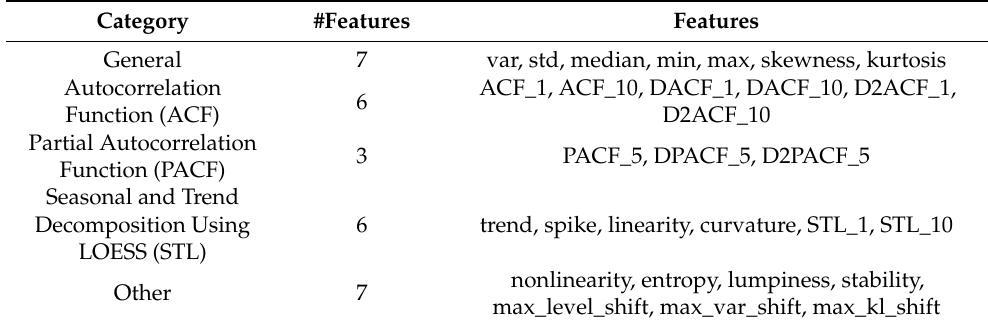
Table 2. List of 29 computed